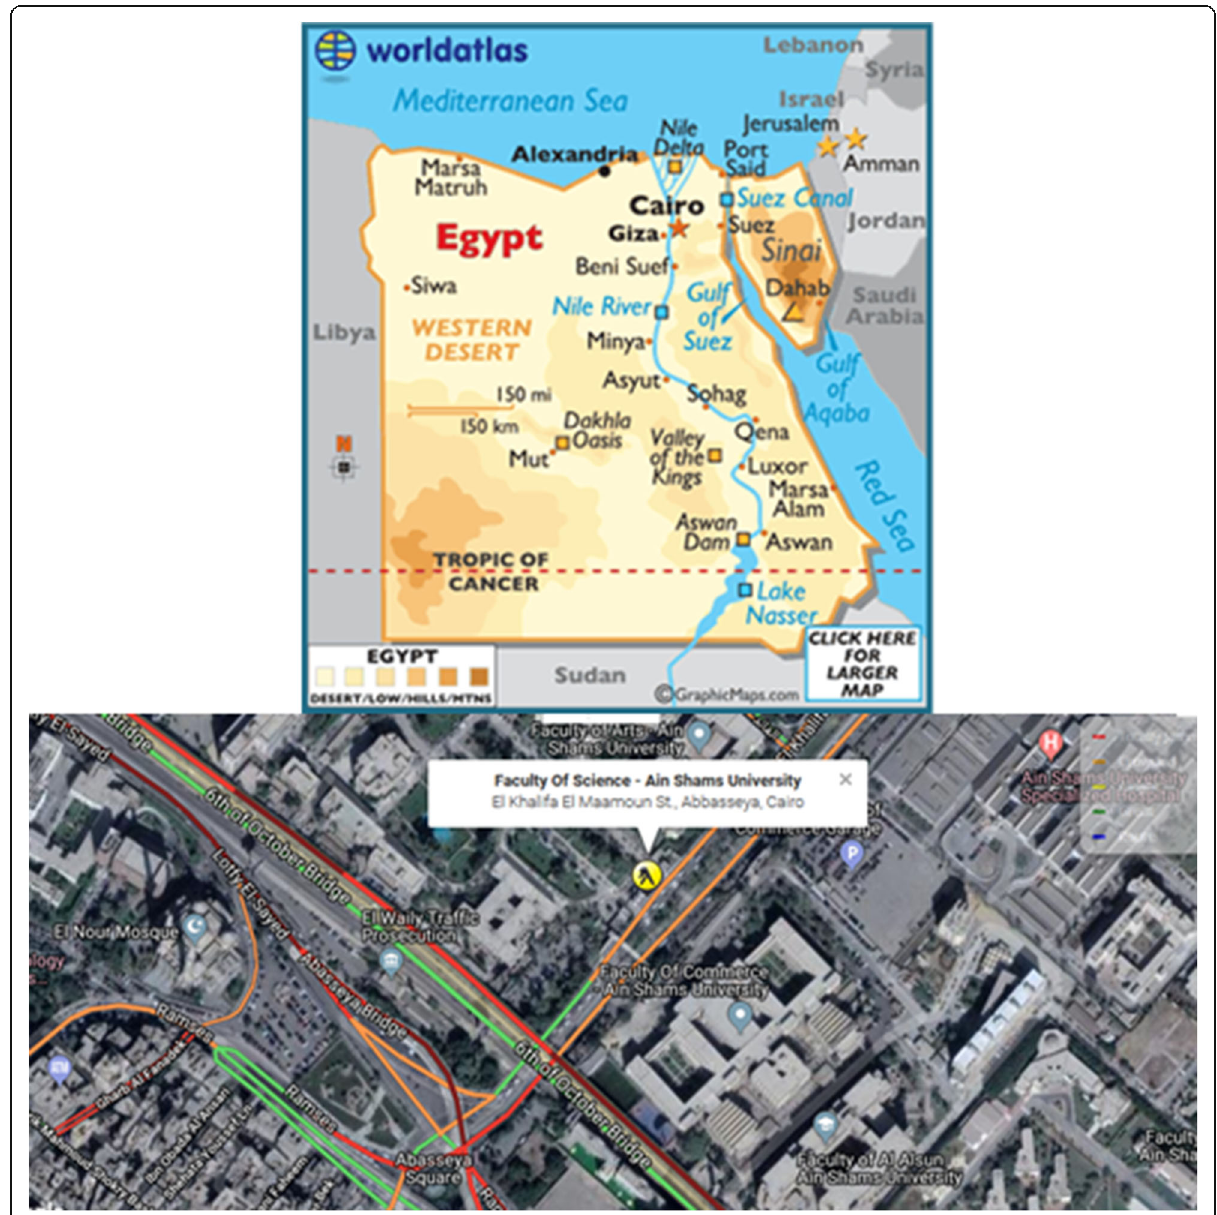
Fig. 1 Map showing the location of the study site at Abbassyia,